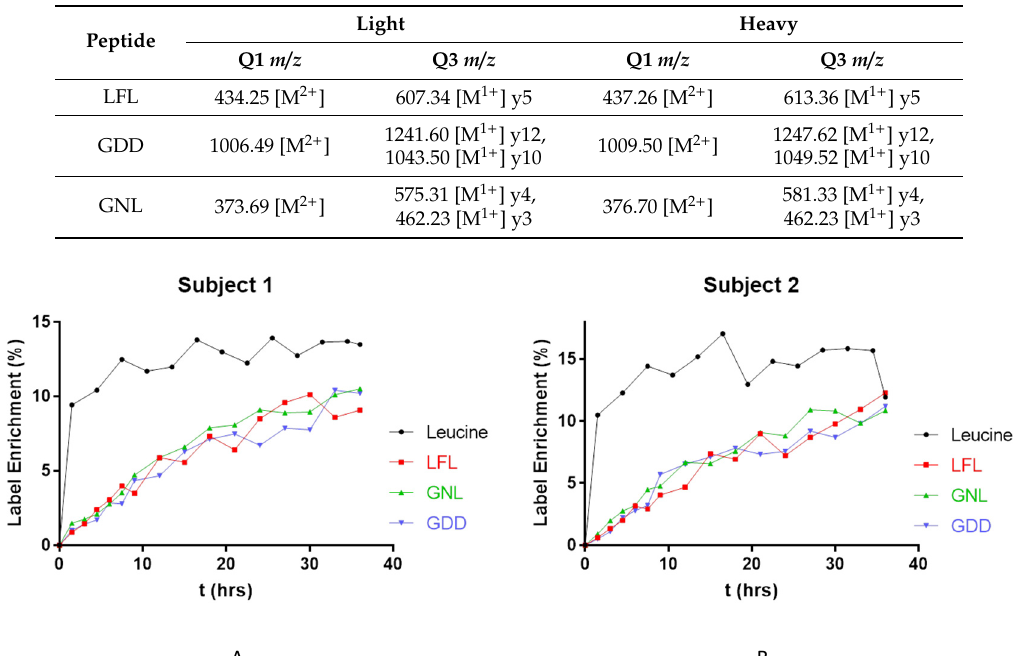
Table 3. Light and heavy peptide ion transitions used for FcRn turnover measurement.